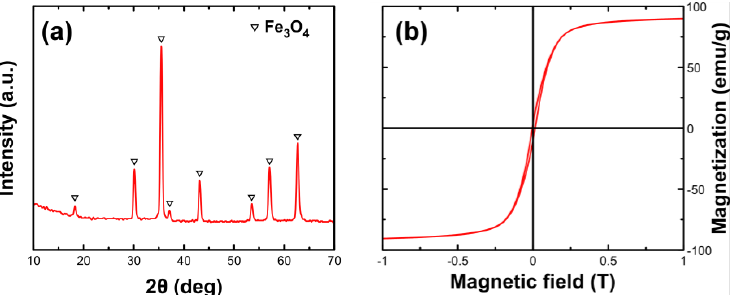
Figure 2. X-ray diffraction (XRD) diagram of the synthesized Fe 3 O 4 nanoparticles ( a ) and Figure 2. X-ray di ff raction (XRD) diagram of the synthesized Fe 3 O 4 nanoparticles ( a ) and corresponding corresponding magnetic hysteresis loop at room temperature ( b ). magnetic hysteresis loop at room temperature ( b